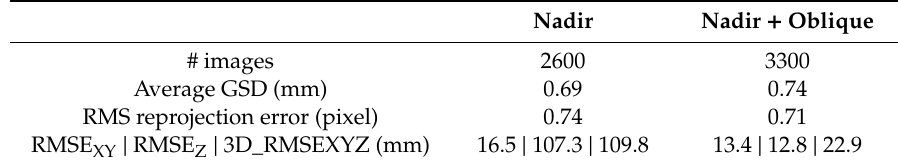
Table 8. Self-calibrating free-network BA solutions for the 50 × 10 m fore reef plot.